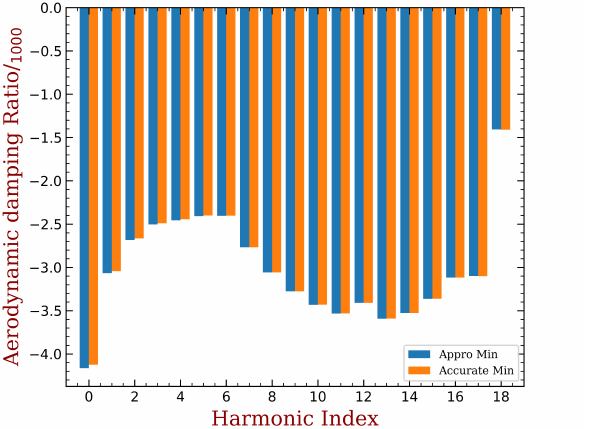
Figure 9. Interpreting the aeroelastic damping with alternate (also h = 18 wave) mistuning. The mistuning modes are sorted by natural frequencies in ascending order. The mapping between the tuned modal index and NDI is shown in Equation (4). ( a ) Damping ratio reconstructed by Equation (29), ( b ) the weight of tuned modes to the least damping mistuning mode.